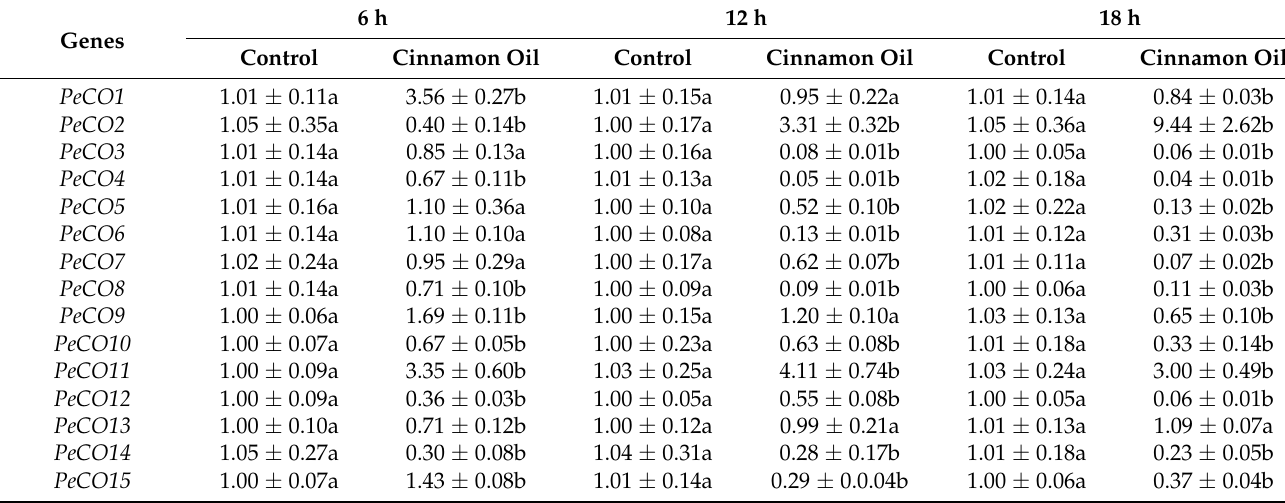
Table 1. Effects of cinnamon oil on the expression of genes involved in the carbohydrate metabolic process in P. expansum.